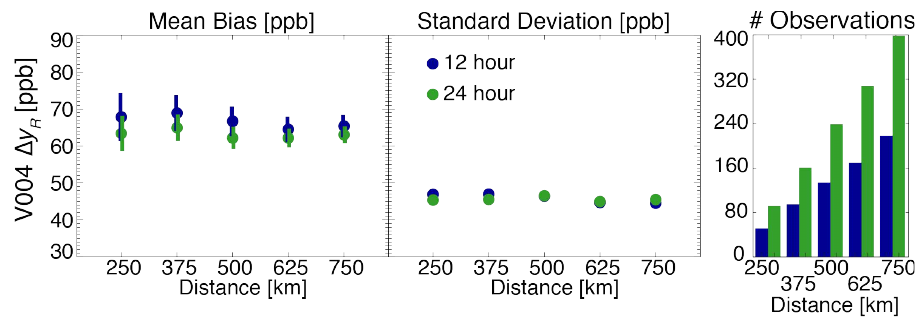
Fig. 2. The left panel shows flight paths of HIPPO missions I and II during January and October–November 2009 respectively. Center and right panels show methane concentrations as a function of latitude and pressure measured during southbound and northbound flight paths of HIPPO I and II. Black lines show the aircraft profiles with methane data. Solid contours are interpolated.